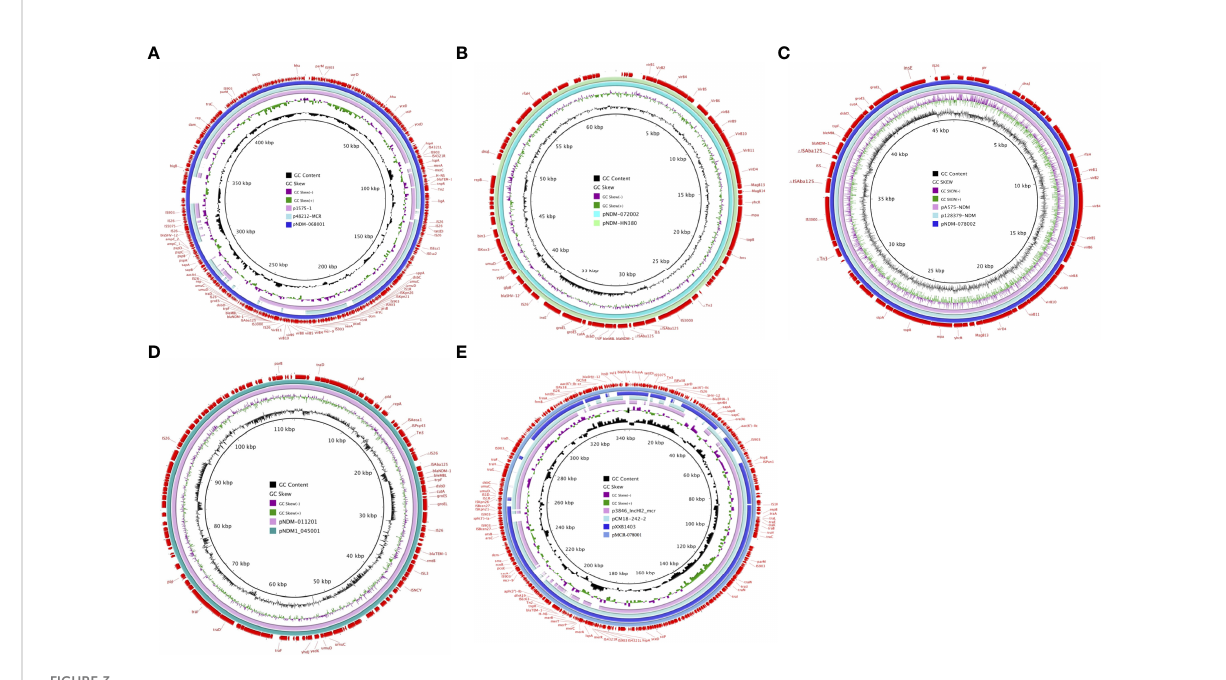
FIGURE 3 Schematic maps of plasmids harboring bla NDM-1 and mcr-9 . (A) Circular alignments of the plasmids pNDM-068001 , p1575-1 (accession no. CP068288), and p48212-MCR (accession no. CP059413). (B) Map of the plasmids pNDM-072002 and pNDM-HN380 (accession no. NC_019162). (C) Map of the plasmids pNDM-078002, pA575-NDM (accession no. MH917283), and p128379-NDM (accession no. MF344560). (D) Map of the plasmids pNDM-011201 and pNDM1-045001 (accession no. CP043383). (E) Circular alignments of pMCR-078001 sequences with homologous mcr-carrying contigs p3846-IncHI2-mcr (accession no. CP052871), pCM18-242-2 (accession no. CP050507), and pXXB1403 (accession no. CP059887). Genes and open reading frames (ORFs) are labeled in the outermost circle. Truncated genes are indicated by D